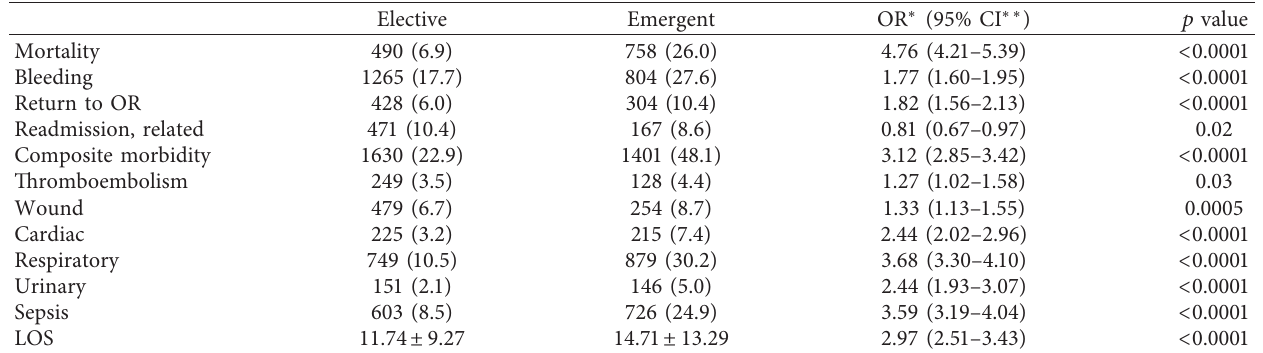
∗ Odds ratio. ∗∗ Confidence